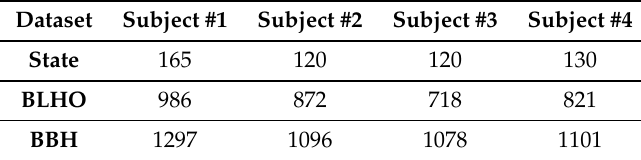
Table 4. Number of 5-s executions for each subject of the CogAge dataset.